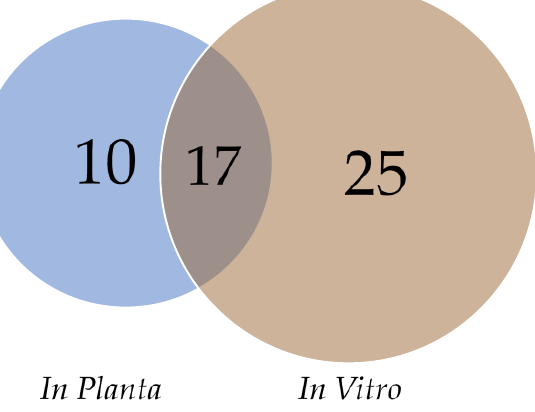
Figure 5. Venn diagram for the effector genes differentially expressed depending on the conditions (in vitro or infected plant samples).